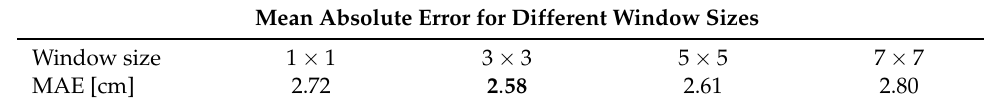
Table 5. MAE on the S 3 dataset for different window sizes. Noise level is σ v = 0.02. The best performance (in bold) is achieved with a 3 × 3 window size.